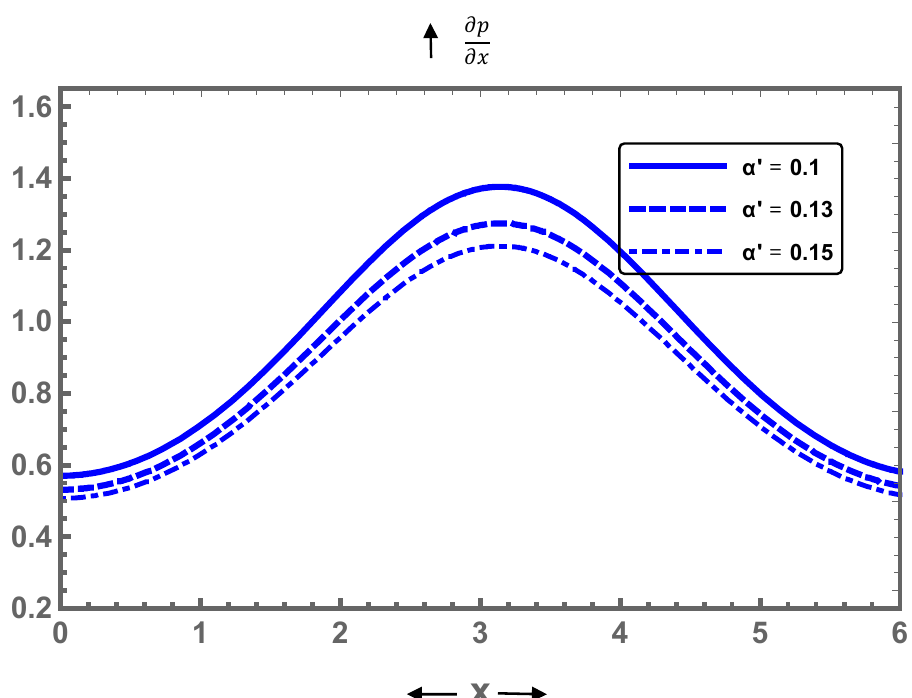
Figure 21. Display of pressure gradient for different values of m .